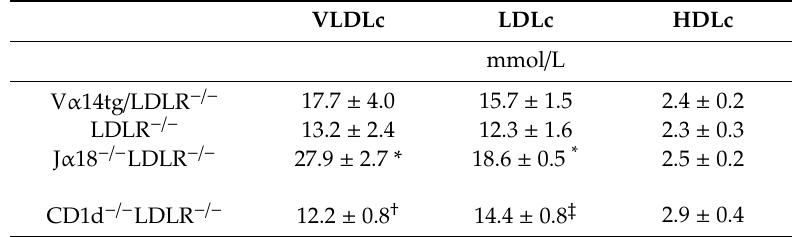
Table 1. Plasma lipoprotein cholesterol levels in female mice after 12-weeks of Western type diet (WTD) ( n = 7–13). * p < 0.001 vs. LDLR − / − † p < 0.0002 vs. J α 18 − / − LDLR − / − ‡ p < 0.01 vs. J α 18 − / − LDLR − / − .